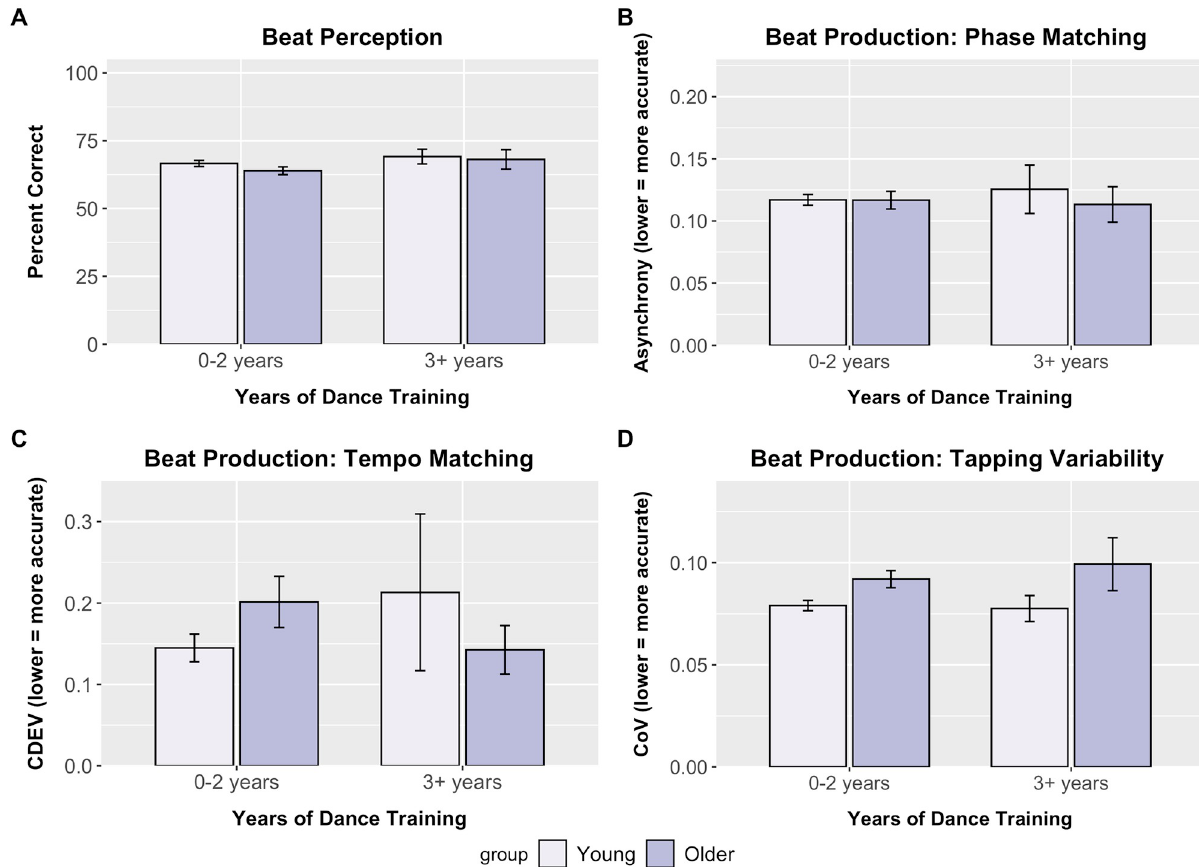
Fig 2. Dance training effects on beat perception and production. Performance broken down by group (young, older, Parkinson’s disease) and dance training (0–2 years, 3+ years) for beat perception (A), beat production phase matching (B), beat production tempo matching (C), and beat production tapping variability (D). No significant differences were present for beat perception, phase matching (asynchrony) and tempo matching (coefficient of deviation). Tapping variability did differ between groups. Error bars indicate the standard error of the mean.